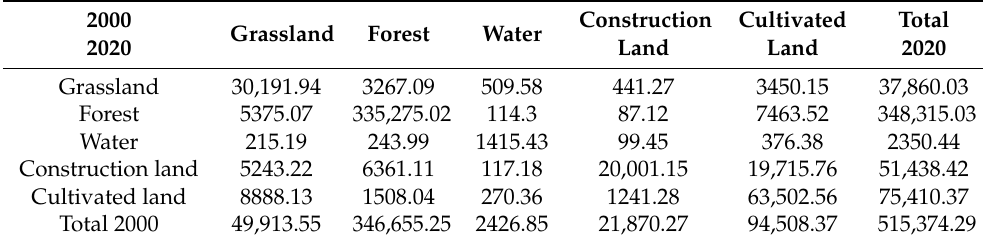
Table 6. Land-use area transfer matrix from 2000 to 2020 (unit: hm 2 ).